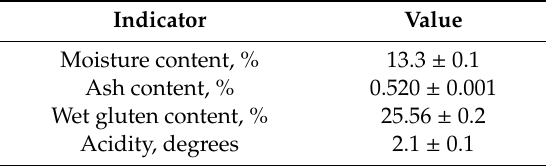
Table 1. Physicochemical indicators of the wheat flour used in bread